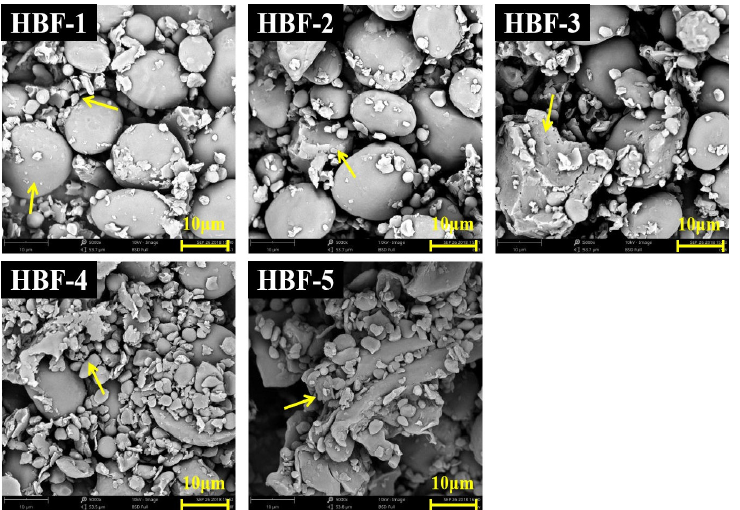
Figure 1. SEM images of highland barley flour with different particle sizes (5000×). HBF-1, HBF-2, HBF-3, HBF-4 and HBF-5 are highland barley flours with median particle size of 223.25, 143.12, 90.73, 42.33 and 19.26 μm, respectively. The yellow arrows in the figure represent highland barley flours with different